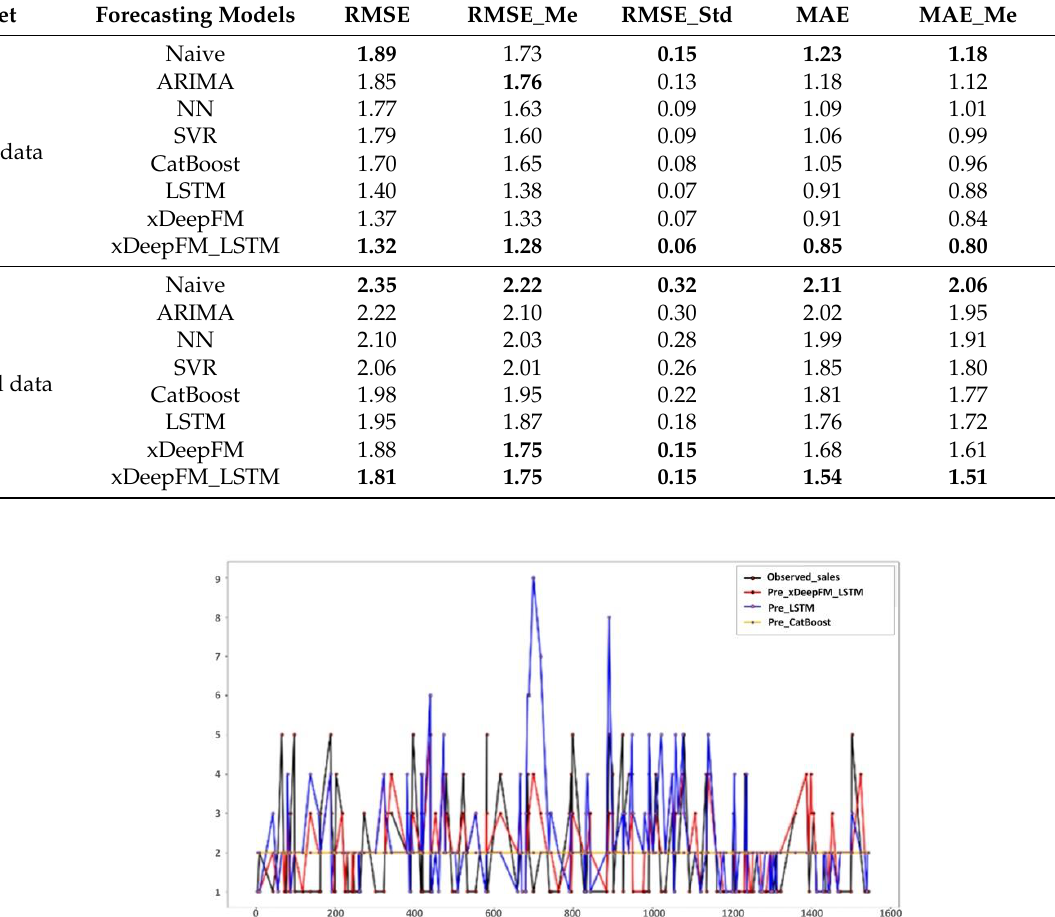
Table 2. Comparison of error values for each model under real-life and simulated data.